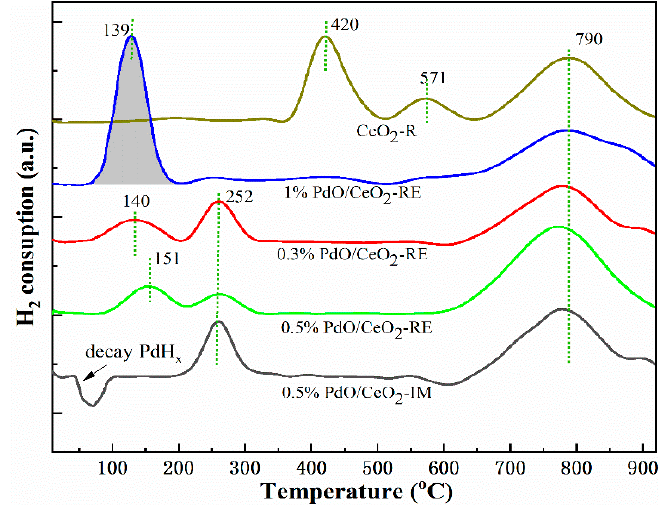
Figure 6. H 2 -TPR profile of CeO 2 -R and Pd/CeO 2 catalysts.